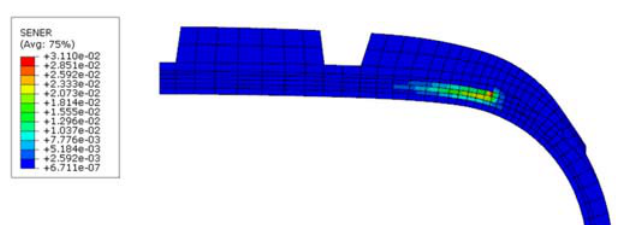
Fig. 4. Strain energy density obtained by FE analysis of axisymmetric model Experimental design and FE analysis simulation results